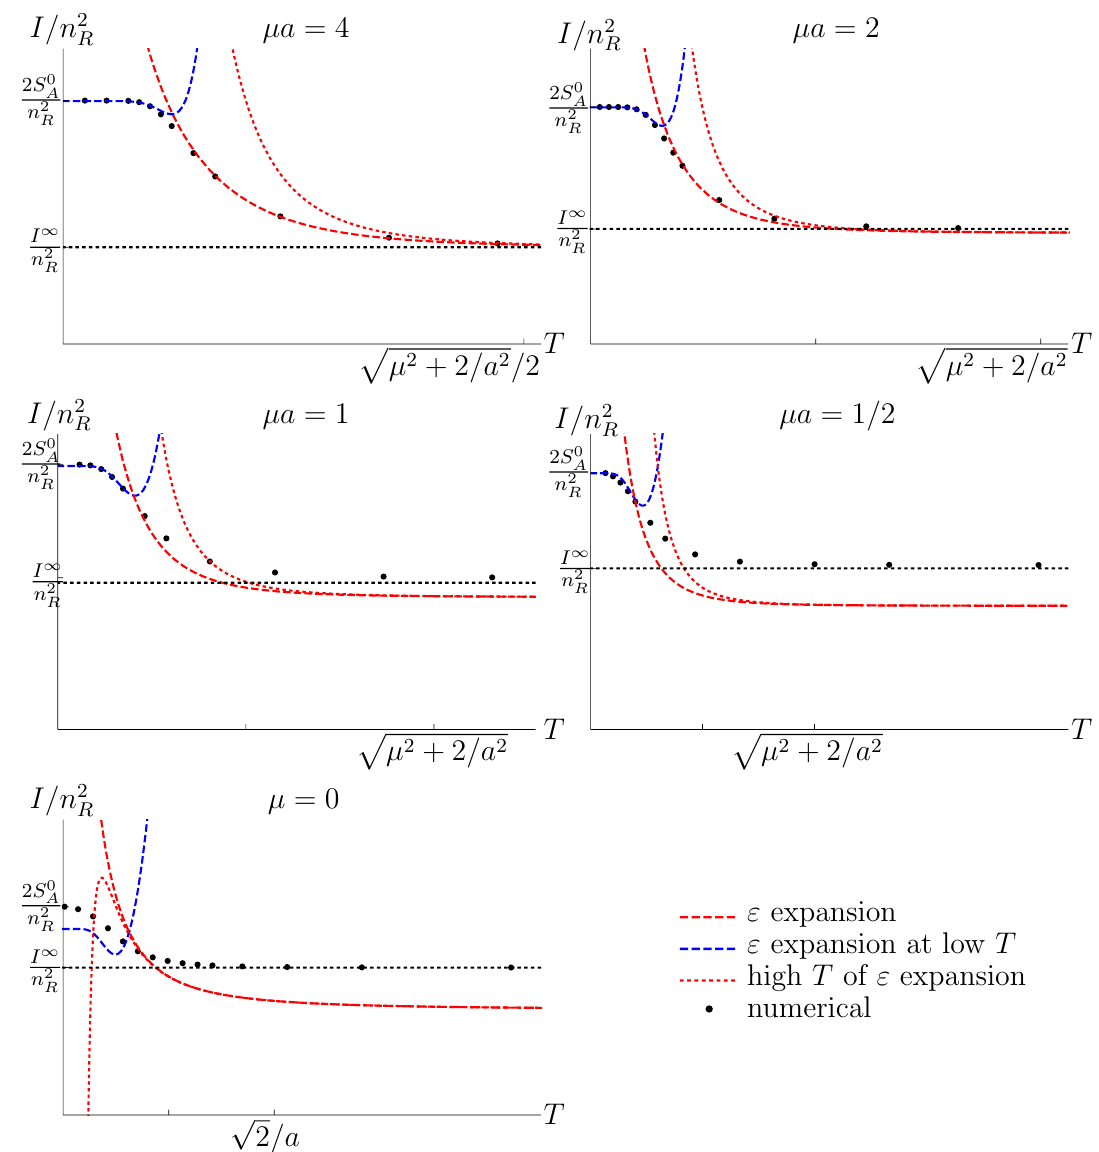
Figure 6 . The area law term coe(cid:14)cient of the mutual information as function of the temperature p with an angular momentum cuto(cid:11) l max = 2 (cid:25)R=a . The dashed lines are the low and high tem- perature expansions of the mutual information, whereas the dotted lines are the asymptotic values for T ! 1